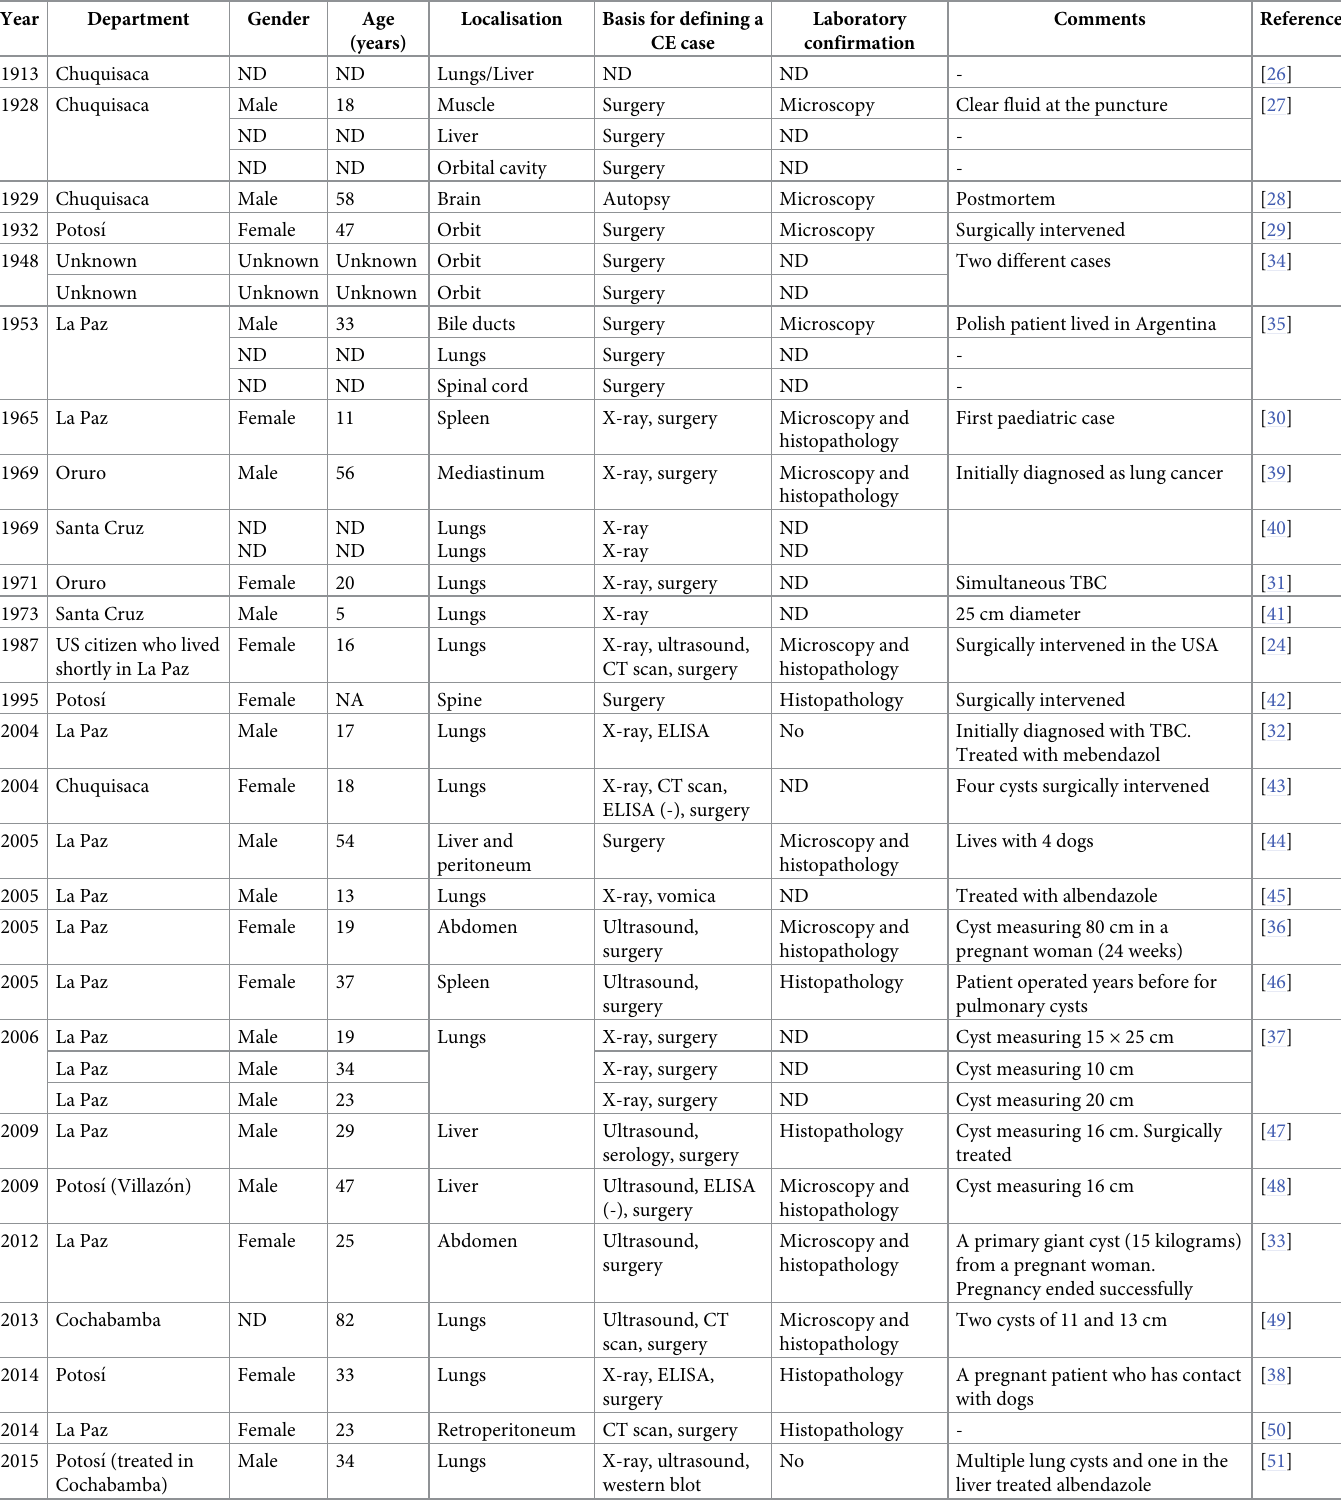
Table 1. Chronological overview of case reports of human CE patients from Bolivia between 1913 and